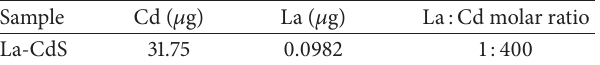
Table 3: ICP-OES quantitative analysis of La-doped CdS. The doping ratio of La: Cd is 1: 50 in precursor solution. And the real doping ratio of La :Cd is 1:400 which we measured in the